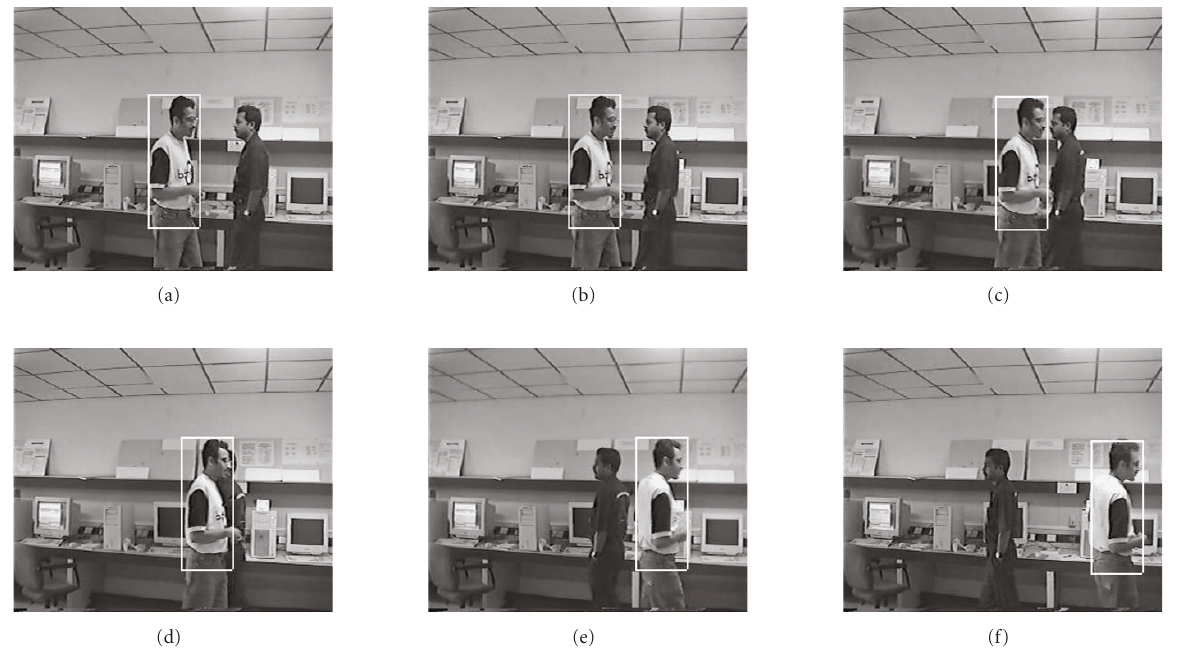
Figure 13: Results on tracking a full body (at t = 4,6,10,14,25,35) in a video sequence where two men are crossing each other.